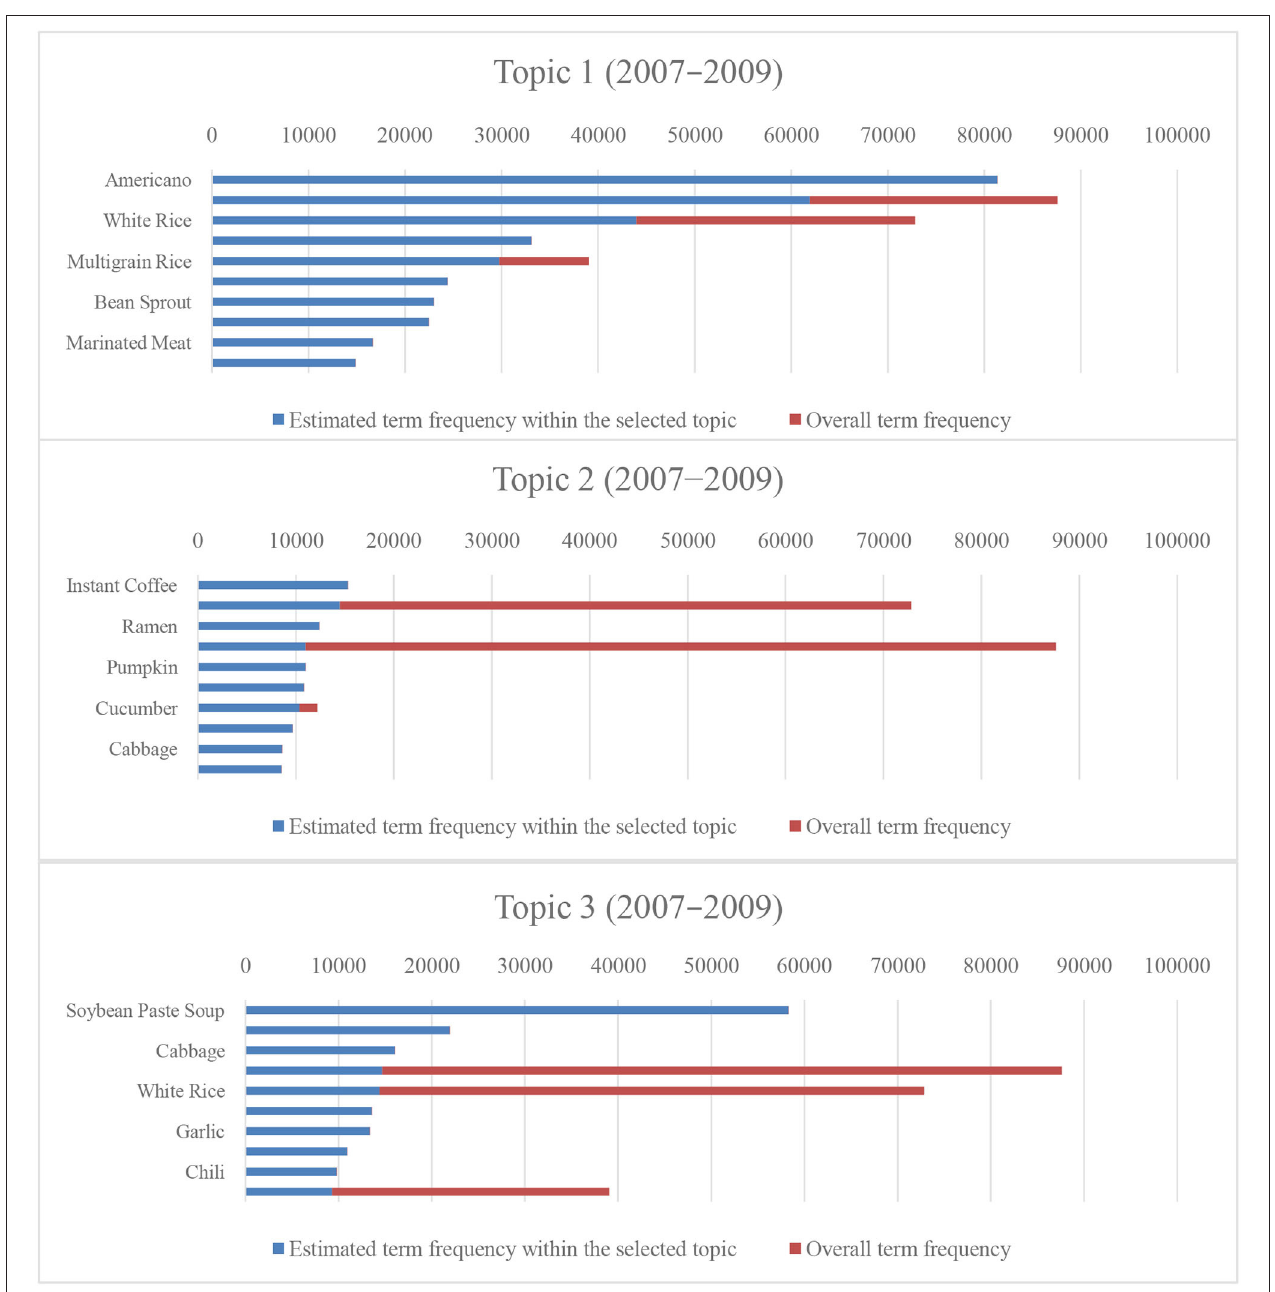
FIGURE 6 | Number of tokens and proportions of entire tokens for the top 10 menus (2007–2009).